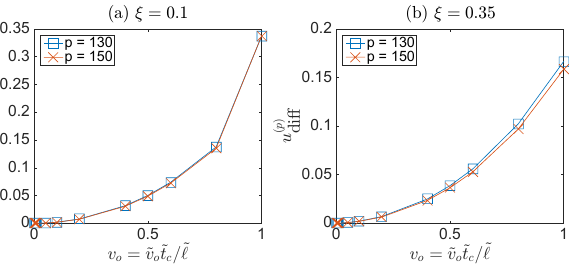
Figure 4. The nonlinear increase in u (p) (a parameter which shows diff dissimilarity between linear and nonlinear space–time responses) with initial impulse velocity ( v o ). The value v o = 0 . 05 is in the zone where linear and nonlinear space–time responses are almost identi- cal.